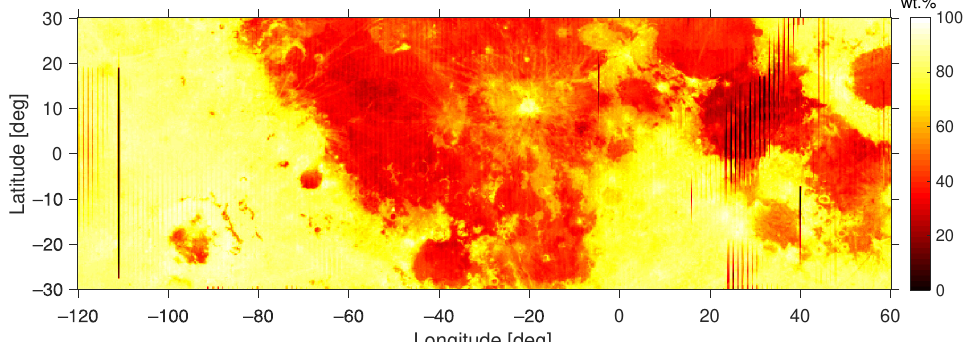
Figure A3. Plagioclase content in the equatorial regions. Data from Lemelin et al.